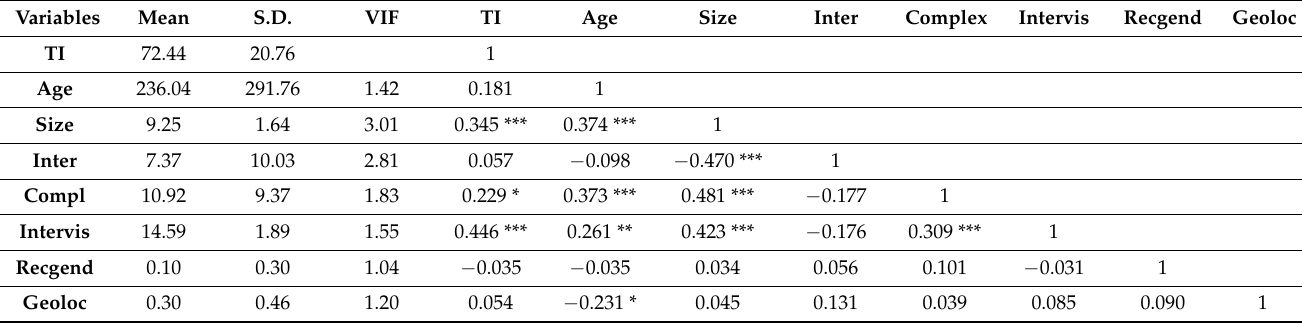
Table 3. Mean, standard deviation, VIF, and correlation.